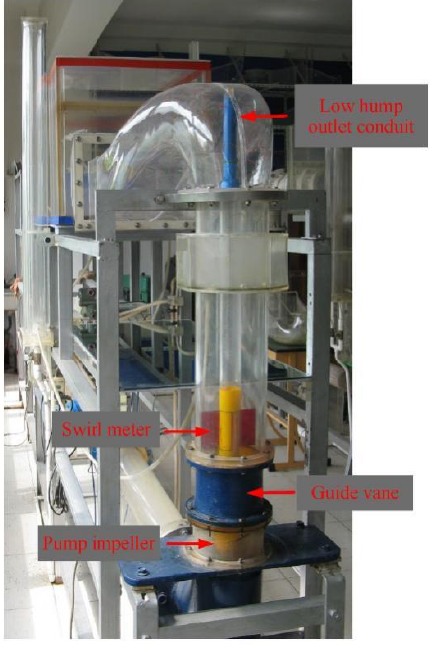
Figure 8. Model test device of low hump outlet conduit.